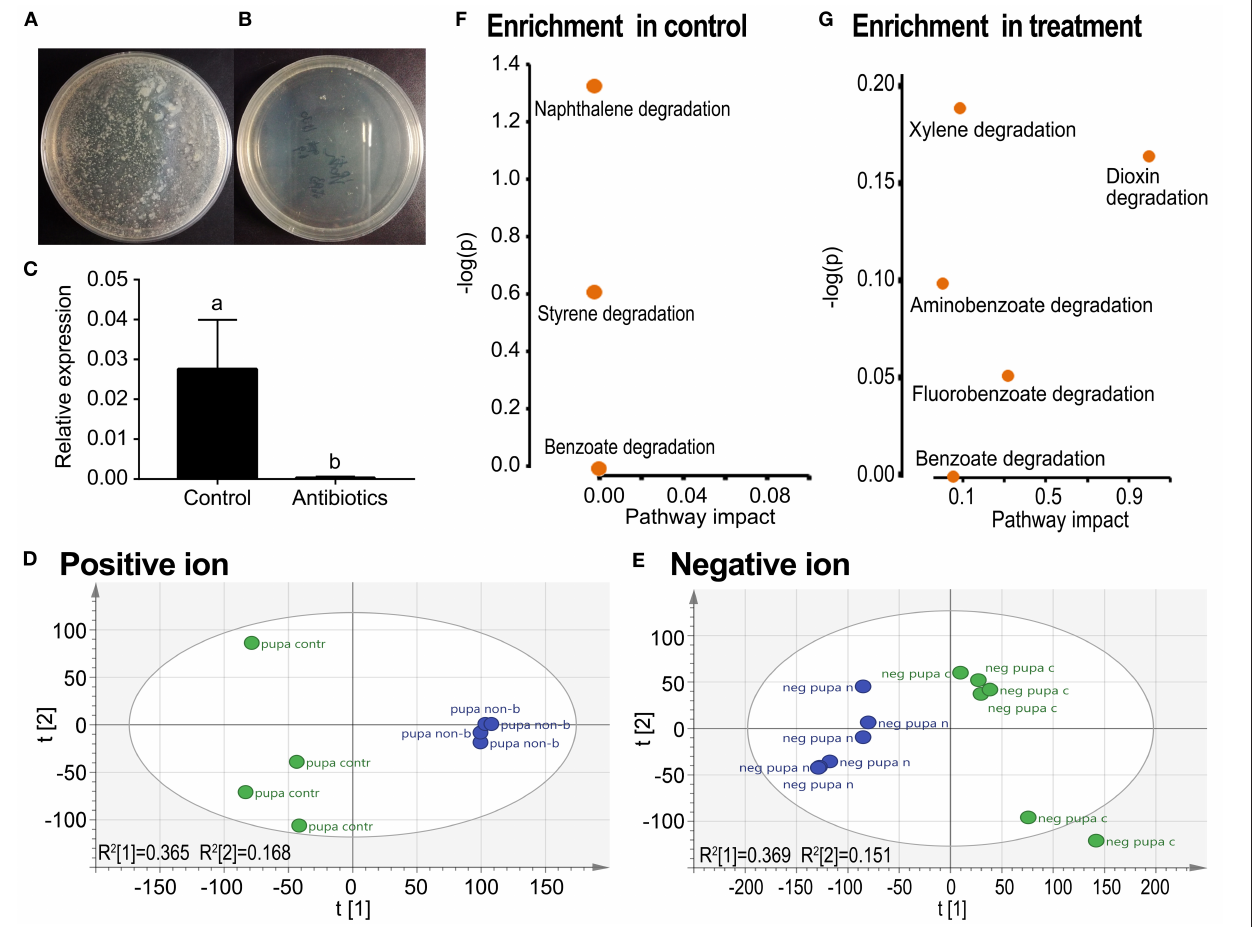
FIGURE 3 | Grouping comparison of metabolomics in control and antibiotic-fed pupae in L. decemlineata . The removal of bacteria was examined by plate culture (A,B) and qRT-PCR using a pair of universal primers of 16S rDNA from the Domain Bacteria (C) . Relative expression level of 16S rDNA was calculated by the 2 − 11 CT method. Different letters indicate significant difference at p -value < 0.05 using analysis of variance with the Tukey–Kramer test. The UPLC-Q-TOF-MS resultant data were analyzed by PCA. Positive and negative ion mode PCA score maps (D,E) and pathway enrichment analyses (F,G) in control vs. antibiotic-fed pupal samples are shown. Green and blue colors in the (D,E) represented control and aposymbiontic pupal groups and each point represented a sample.